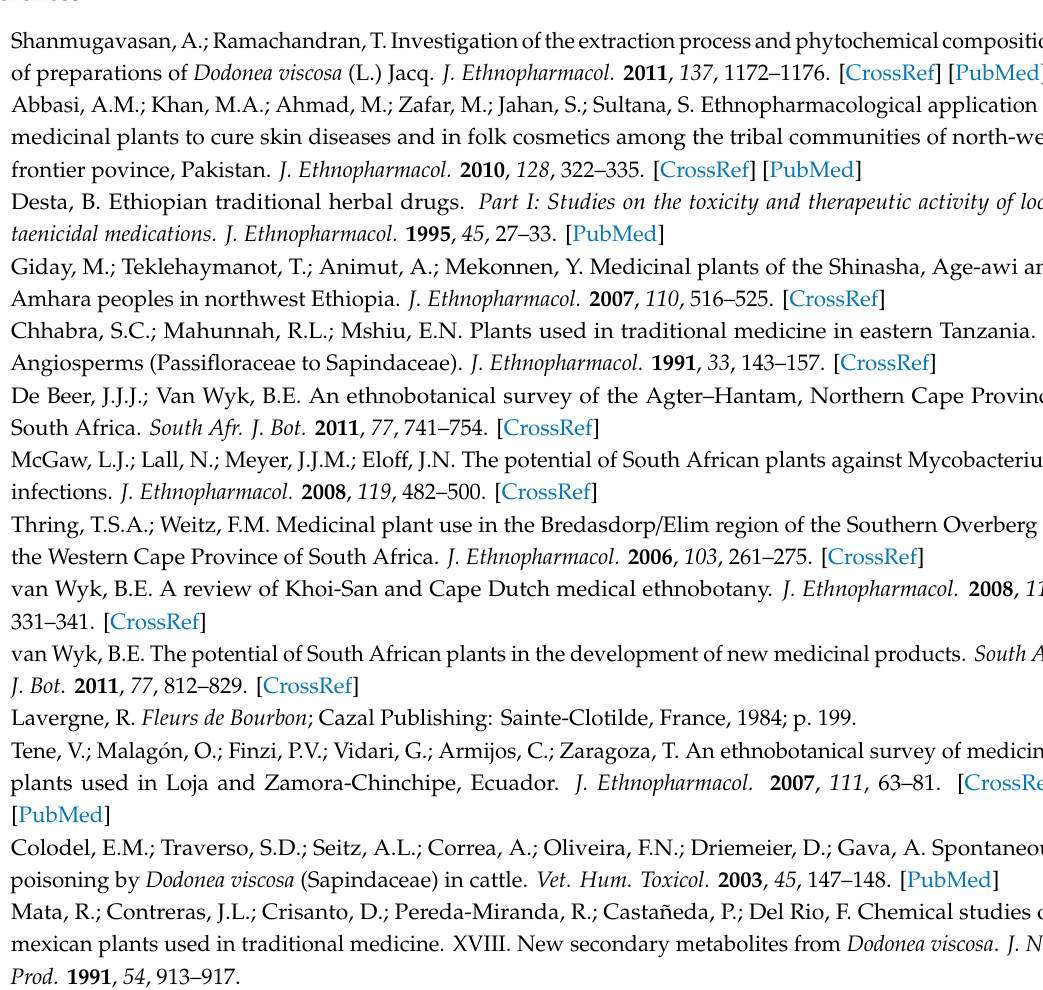
Supplementary Materials: The following are available online: Figure S1-S11: NMR data of 1. Figure S12: ( + )HRESIMS spectrum of 1. Figure S13: EI-MS spectrum of 1. Figure S14: 1 H NMR spectrum of 3. Figure S15: ( + )HRESIMS spectrum of 3. Figure S16: EI-MS spectrum of